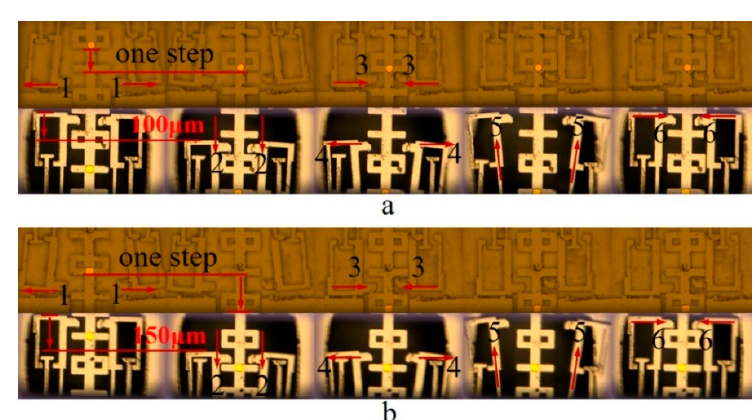
Figure 14. The working process of the pawls meshing with the slider. ( a ) The step with a pulling voltage of 13.5 V. ( b ) The step with a pulling voltage of 14.8 V.